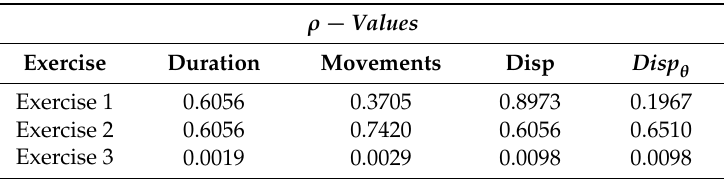
Table 10. Results from Kruskal-Wallis test for each exercise. In the case of exercises 1 and 2, results of the statistical test show that the IGlove responds in the same way in the case of exercises that are not suitable to assess dexterity. By contrast, the low ρ − values found for exercise 3 indicate a significant difference between groups, therefore, variables Duration , Movements , Disp and Disp θ , acquired during FMS test can be used to assess dexterity using the